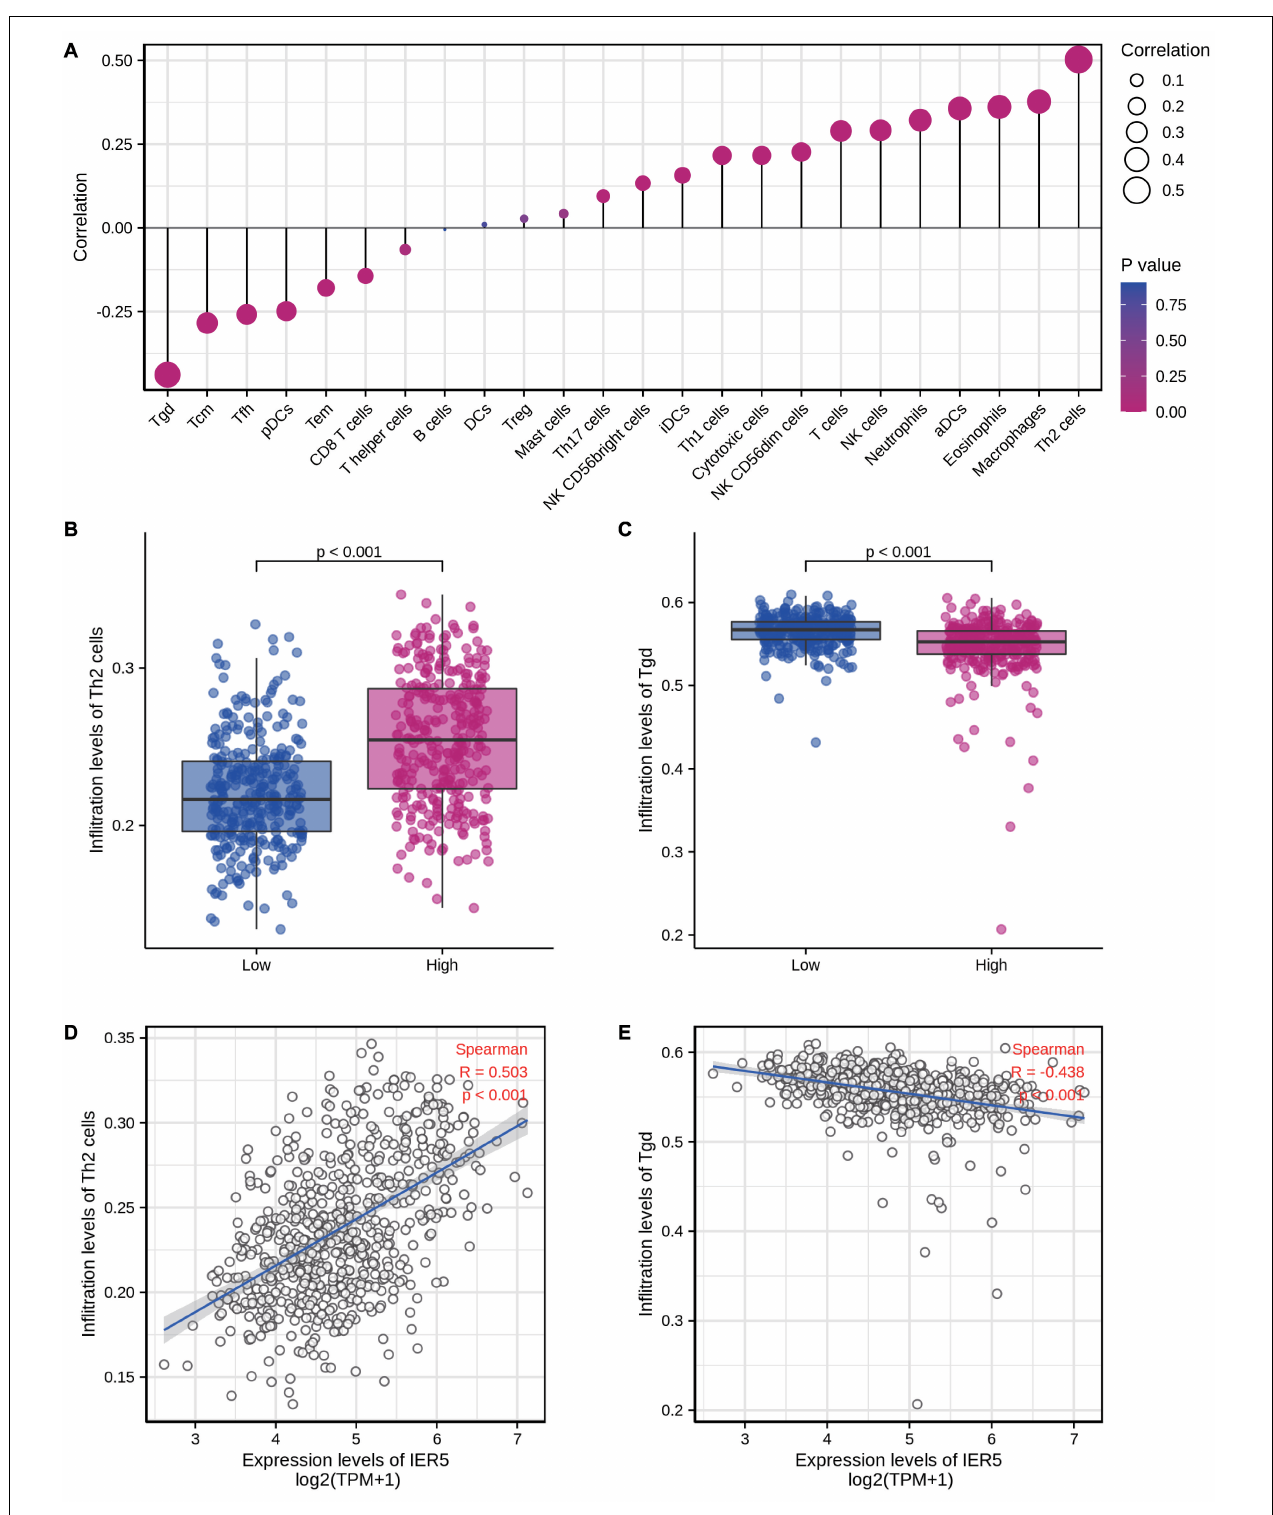
FIGURE 10 | The expression level of IER5 was associated with immune infiltration in the tumor microenvironment. (A) Correlation between the relative abundances of 24 immune cells and IER5 expression levels. (B,C) Infiltration levels of Th2 cells and Tgd cells in the low- and high- IER5 expression groups. (D,E) Correlation between the relative enrichment score of Th2 cells and Tgd cells and the expression level of IER5.